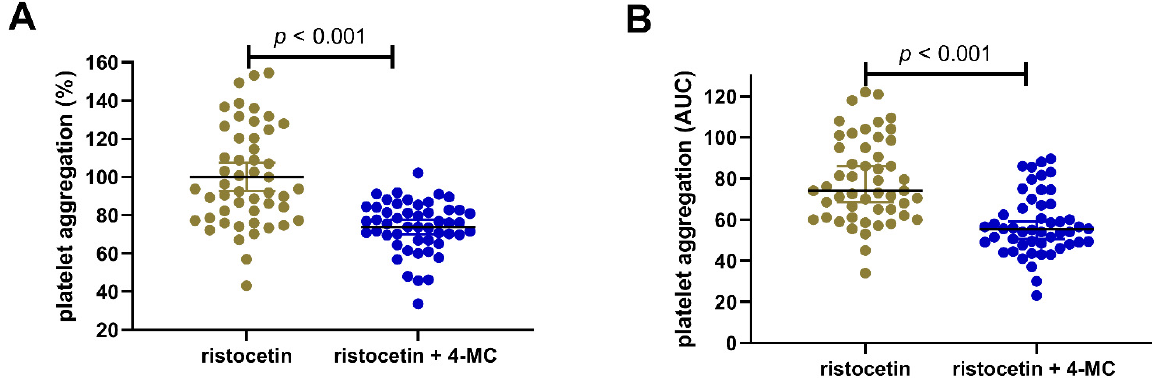
Figure 2. Ristocetin-induced platelet aggregation and the effect of 4-methylcatechol. ( A ) Relative changes vs. the corresponding blank (DMSO + ristocetin), ( B ) Absolute values are expressed as the area under the curve (AUC). The data are shown as the mean ± 95% confidence intervals in the case of relative values and the median ± 95% confidence intervals in the case of AUC. The concentration of 4-MC was 240 μ M. 4-MC—4-methylcatechol.